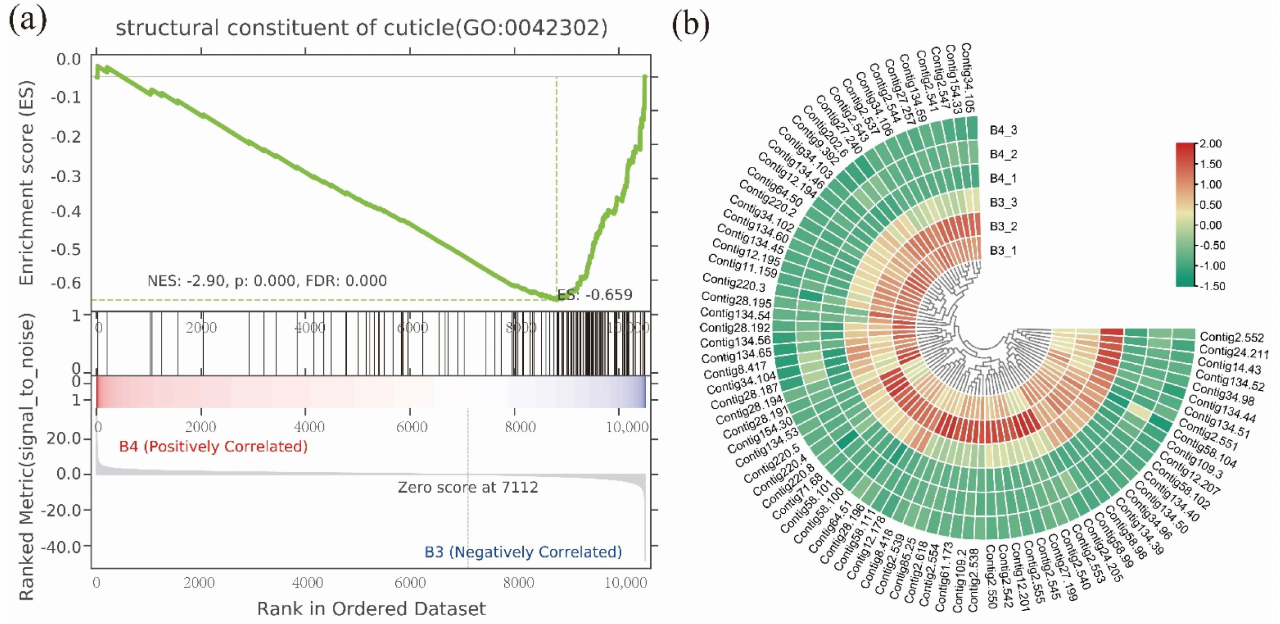
Figure 6. GSEA was performed to analyze the gene sets during postembryonic development. ( a ) GO terms showed that the structural constituent of cuticle was significantly up-regulated in the third instar (B4 vs. B3). ( b ) Expression profiles of genes associated with the structural constituent of cuticle. The color bar on the right shows the FPKM values from red (high) to green